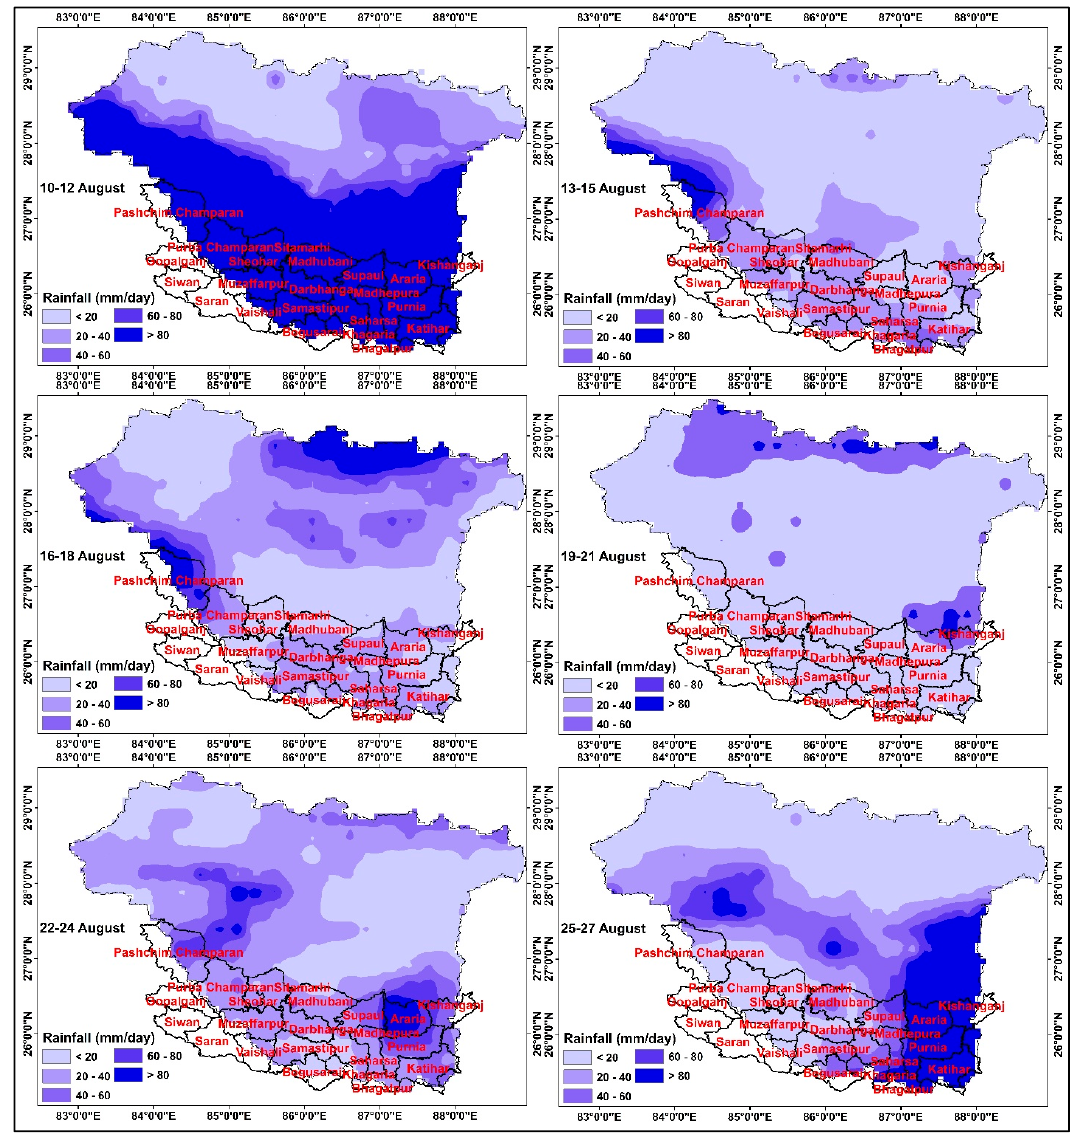
Figure 3. The accumulated spatio temporal rainfall variability (mm) over the North Bihar during the flooding period from 10 to 27th August 2017. The shape file of the North Bihar districts was overlaid to identify the districts receiving heavy rainfall.